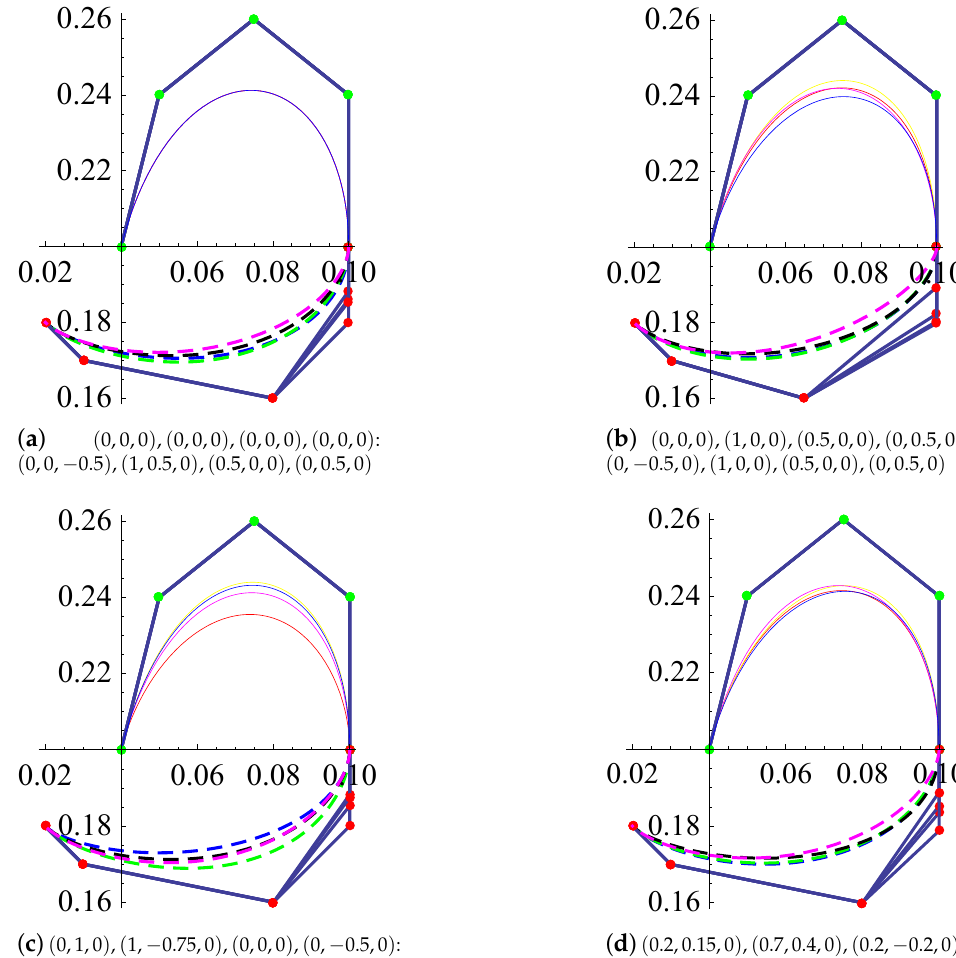
0.75,0 ) , ( 0,0,0 ) , ( 0, 0.5,0 ) : − − 0.2,0 ) , ( 0.2,0.2,0 ) : −